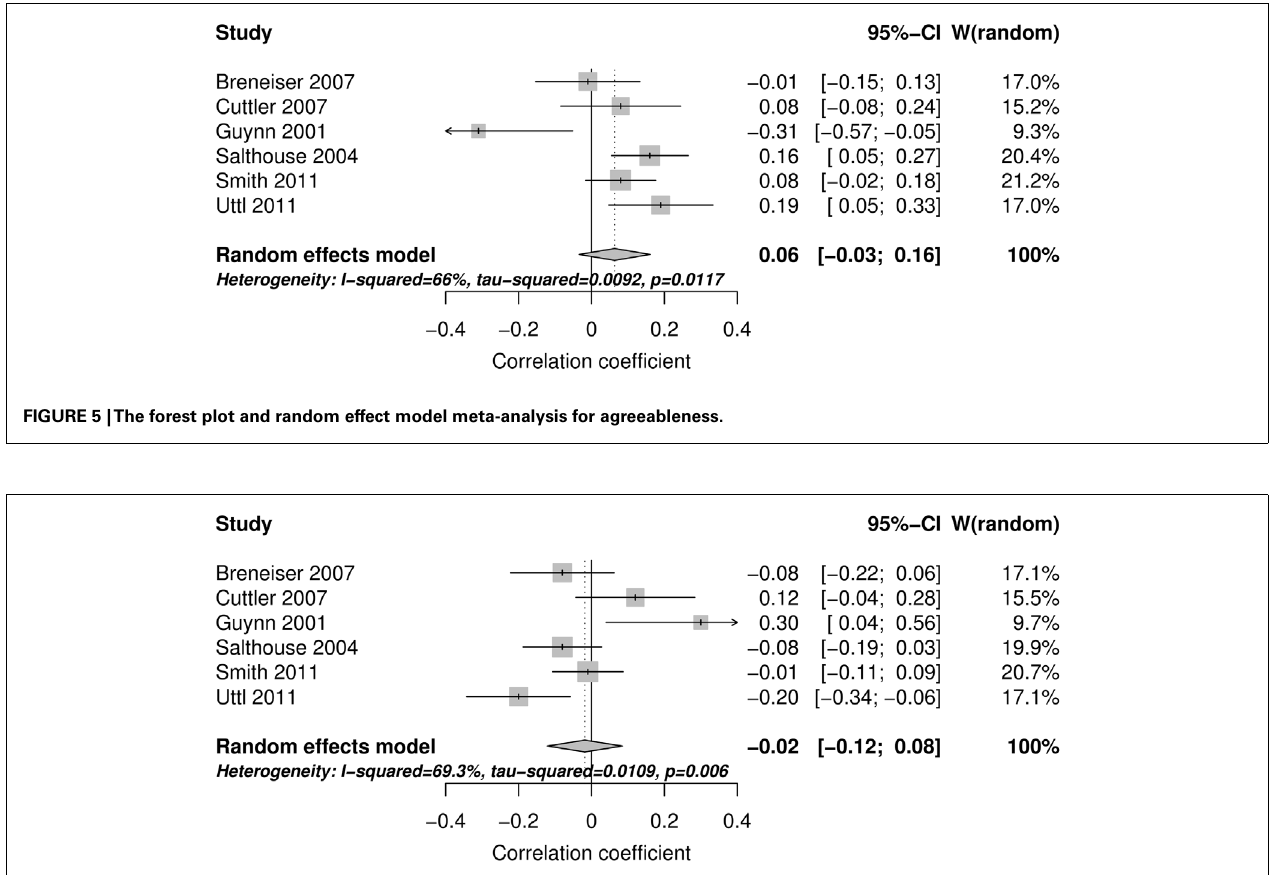
FIGURE 6 |The forest plot and random effect model meta-analysis for